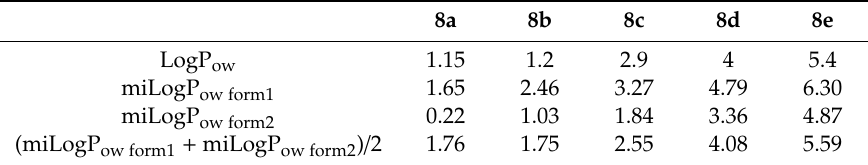
Table 2. Experimental and calculated values LogP ow for 8a–e .